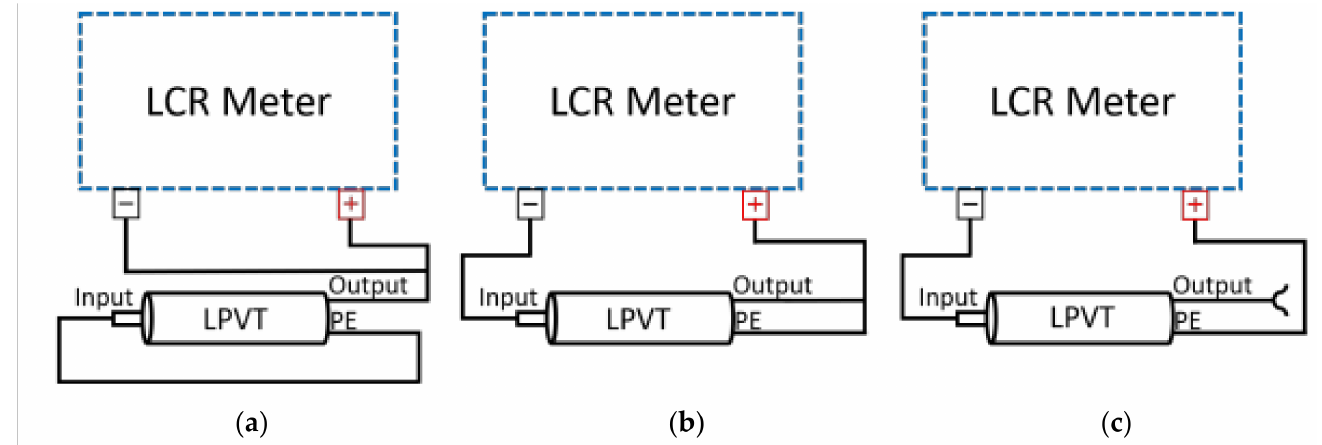
Figure 4. Impedance measurement setup in its three configurations adopted for the tests of the two